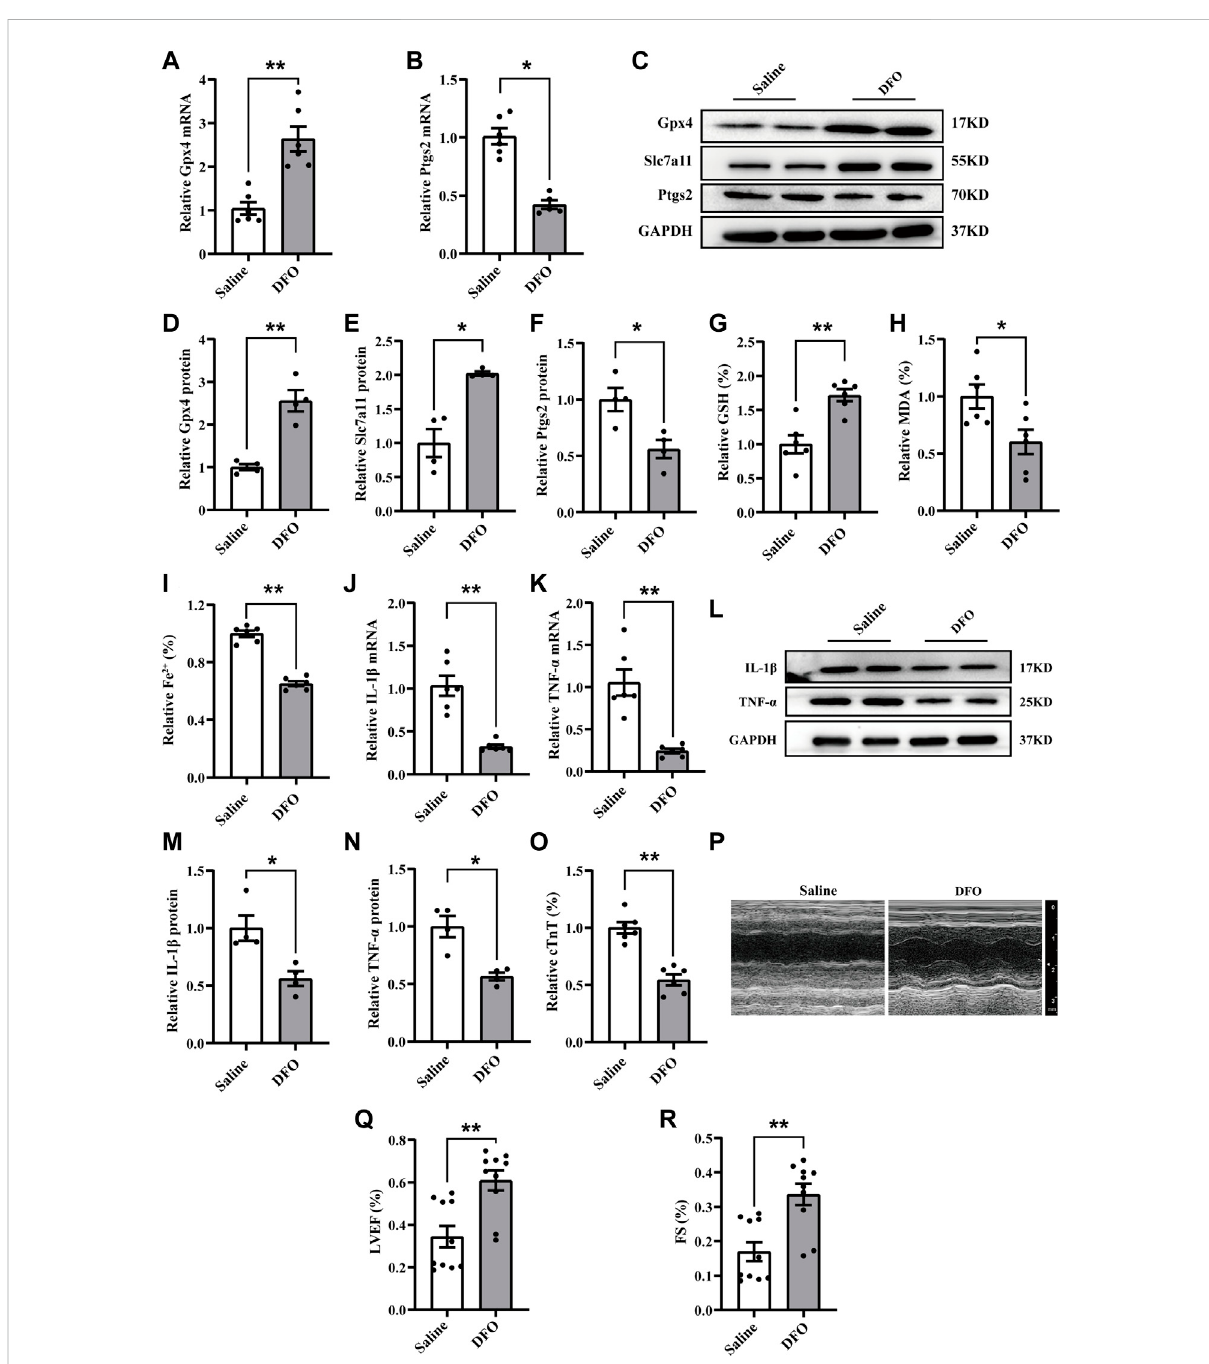
Ferroptosis inhibition attenuated myocardial injury and in fl ammation following CME. (A,B) The expression levels of Gpx4 and Ptgs2 mRNA ( n = 6). (C – F) Western blotting showing the expression of Gpx4, Slc7a11, and Ptgs2 ( n = 4). (G – I) Levels of GSH, Fe 2+ , and MDA in myocardial tissues ( n = 6). (J,K) RT-qPCRwasperformedtoquantifylevelsofIL-1 β andTNF- α ( n =6). (L – N) WesternblottingshowingtheexpressionofIL-1 β andTNF- α ( n = 4). (O) Serum levels of cTnT were decreased in the DFO group ( n = 6). (P – R) Cardiac LVEF and FS detected by echocardiography ( n = 10). GAPDHservedasan internalcontrolandwasperformedtoquantitativelynormalizedtheproteindata.Data arepresentedas thenormalizedmean± SEM (toSaline) or mean± SEM. Values insalines wereaveraged and normalized to 1 (A – O) . * p < 0.05. ** p < 0.01.CME: coronarymicroembolization; DFO: deferoxamine; LVEF: left ventricular ejection fraction; FS: fractional shortening; cTnT: cardiac troponin T; Gpx4: glutathione peroxidase 4; Slc7a11: solute carrier family 7 member 11; Ptgs2: prostaglandin-endoperoxide synthase-2; MDA: malondialdehyde; GSH: glutathione; IL-1 β : interleukin 1 beta; TNF- α : tumor necrosis factor